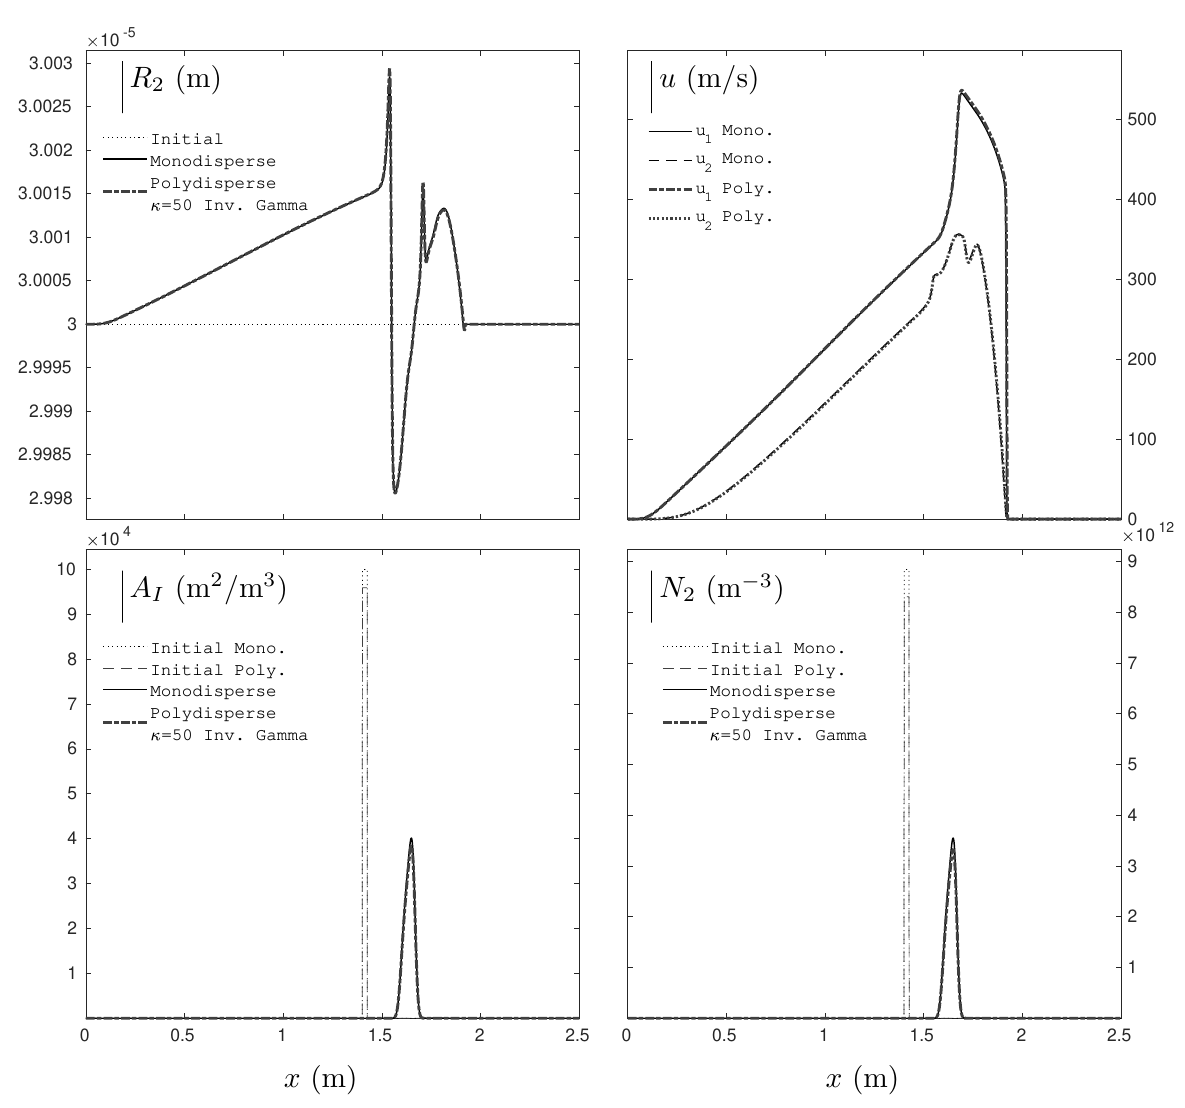
Figure 15: Simplified two-phase explosion test depicted in Fig. 5. Comparison of the monosdisperse and polydisperse results. Figure 15. Simplified two-phase explosion test depicted in Figure 5. Comparison of the monodisperse t =0 = 30 µ m. For the polydisperse computation, the = R t =0 The initial mean radius is the same for both computations R 2 t = 0 = R t = 0 2 = and polydisperse results. The initial mean radius is the same for both computations R 2 2 Inverse Gamma distribution is used with κ = 50. All results are given at time t = 1 . 2 ms and are presented in terms of A I , u , 30 µ m. For the polydisperse computation, the Inverse Gamma distribution is used with κ = 50. N 2 and R 2 for both computations. The two solutions are very close. All results are given at time t = 1.2 ms and are presented in terms of A I , u , N 2 and R 2 for both computations. The two solutions are very